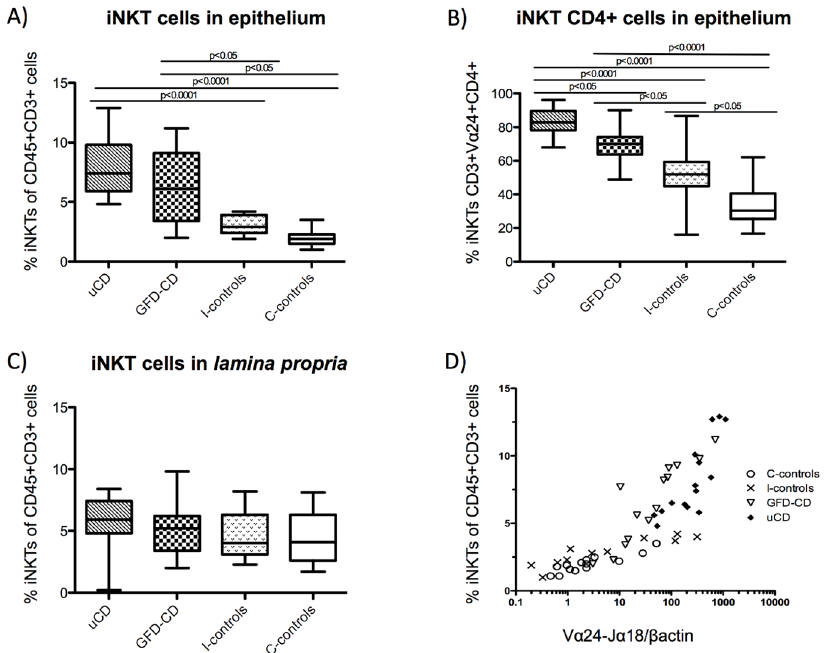
Figure 6. Increased intraepithelial iNKT cells in celiac disease patients and correlation with V α 24 ‐ J α 18 mRNA expression. Percentage of iNKT cells (CD45 + CD3 + V α 24 ‐ J α 18 + ) among the total number of Intraepithelial Lymphocytes (IELs) in untreated Celiac Disease (uCD), Gluten Free Diet ‐ CD patients (GFD ‐ CD), inflamed non ‐ CD controls (I ‐ controls) and non ‐ inflamed non ‐ CD controls (C ‐ controls) ( A ). Percentage of Intraepithelial CD4 + iNKT cells among the total number of iNKT cells in aCD, GFD ‐ CD, I ‐ controls and C ‐ controls ( B ). Percentage of iNKT cells among the total number of Lamina Propria Lymphocytes (LPLs) in aCD, GFD ‐ CD, I ‐ controls and C controls ( C ). Horizontal bars are median values. Statistically significant differences are shown (two tailed Mann Whitney U test; p < 0.05). Correlation between V α 24 ‐ J α 18 mRNA expression, in arbitrary units (AU) and the percentage of iNKT cells among the total number of IELs in aCD, GFD ‐ CD, I ‐ controls and C controls (C ‐ controls: Spearman r = 0.8603, p value<0.001; I ‐ controls: Spearman r = − 0.9455, p value < 0.0001; GFD ‐ CD: Spearman r = − 0.9297, p value < 0.0001; uCD: Spearman r = 0.8287, p value = 0.001) ( D ).